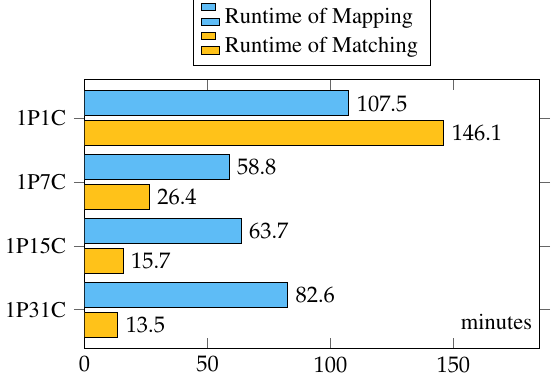
Figure 12. Differences in multi-threading performance. P and C denote the number of producers and consumers respectively.